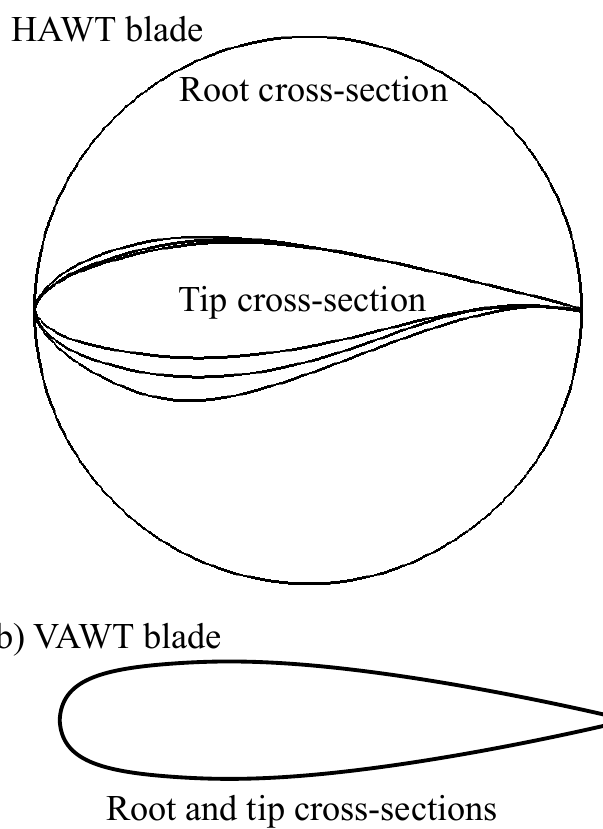
Figure 13. ( a ) Cross-sections of HAWT blade NREL 5 MW and ( b ) cross-sections of VAWT blade with symmetric NACA